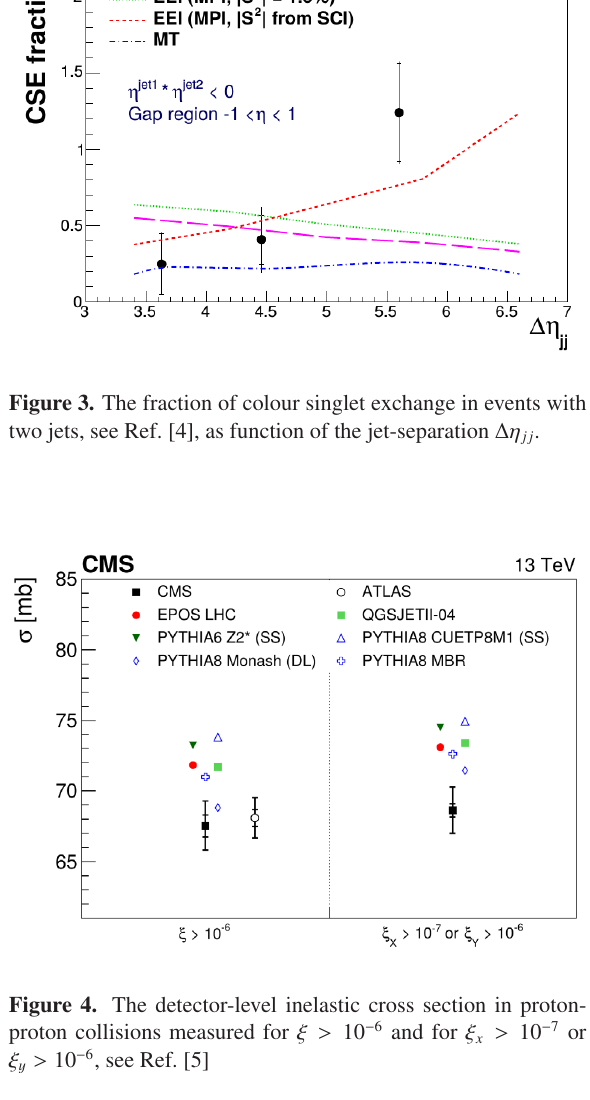
Figure 2. The distribution of the invariant π + π − mass distribution in (semi-) exclusive production, see Ref. [3], measured in proton- proton collisions at 7TeV.